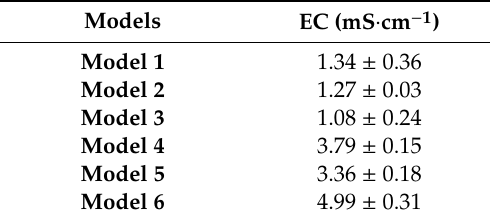
Table 5. Value of soil conductivity of the models.